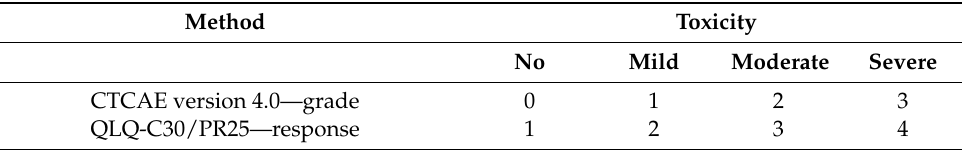
Table 2. Grade-response outcome pairs for concordant outcomes of no, mild, moderate, and severe toxicity,